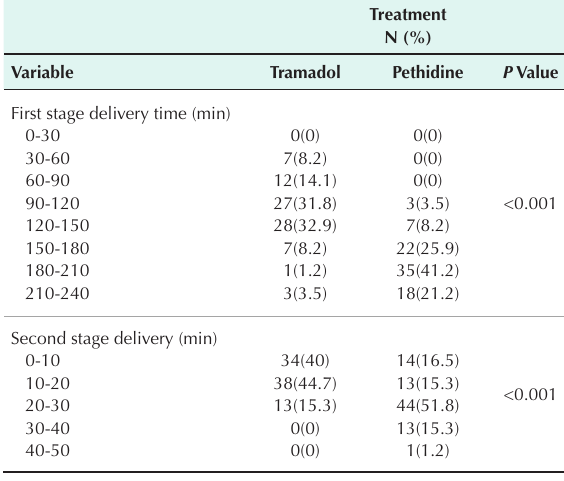
Table 1 . Relationship between delivery time and treatment